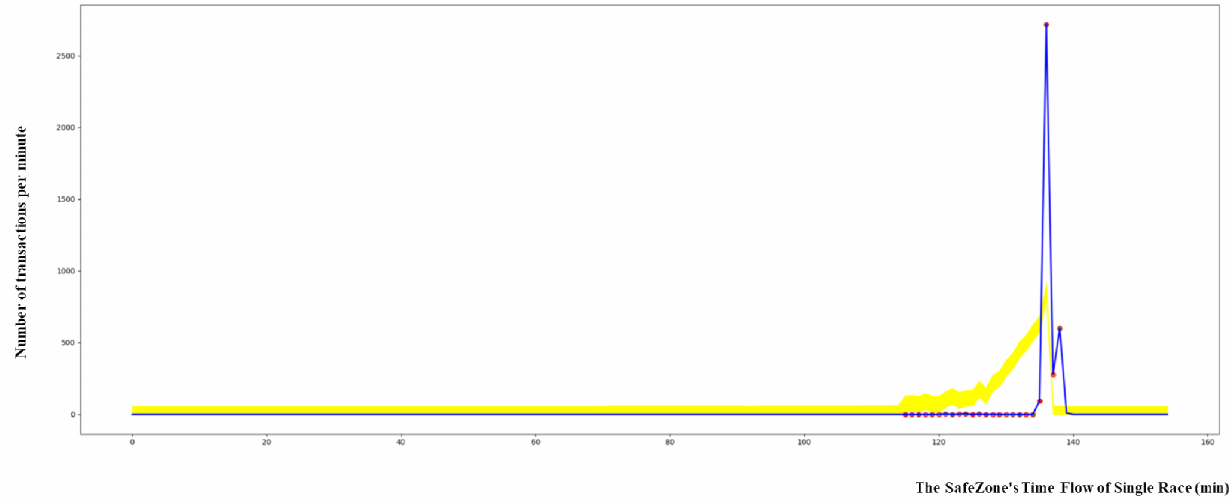
Figure 6. Outcome of a race at Walkerhill with application of the